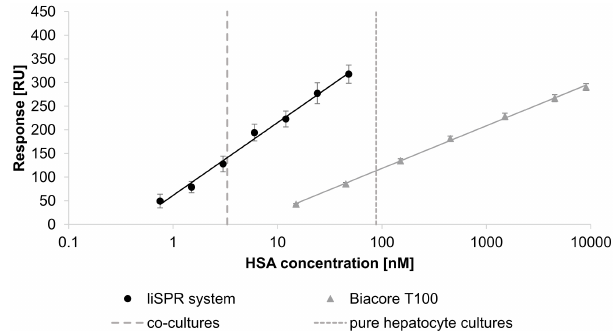
Figure 4. Comparison of the calibration curves obtained with the li SPR system and Biacore T100 in relation to the minimal HSA con- centrations reportedly detected in co-cultivated and pure hepatocyte cultures in the multi-organ chip presented by Wagner et al. (2013). The signals arising from the reference antibodies were subtracted from those arising from the HSA-specific antibodies. Error bars in- dicate the deviations of means obtained from four replicates using the li SPR system and two replicates using the Biacore